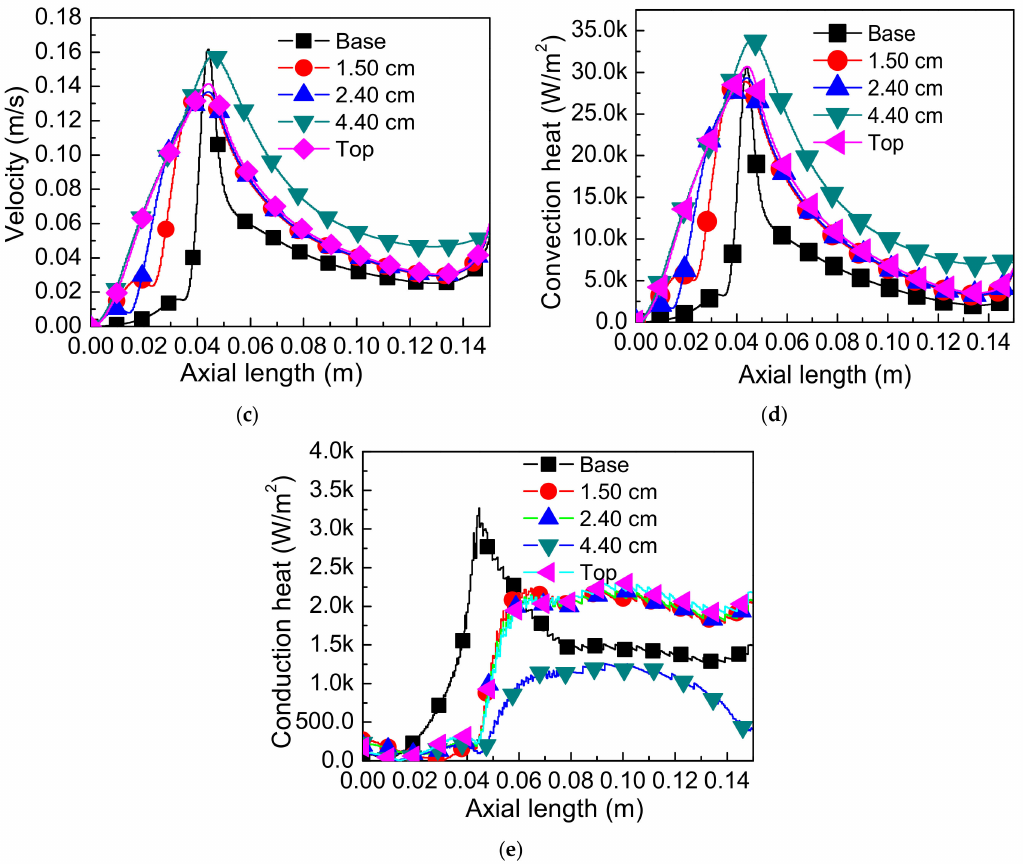
Figure 9. The distribution flux along the reactor at 150 kW / m 2 incident flux. 1 atm and 1.8 L / h for di ff erent fluid inlet positions: ( a ) Temperature distribution of the inlet positions from the base frustum; ( b ) Temperature distribution of the inlet positions from the top of the frustum; ( c ) Velocity distribution of inlets from the base of the frustum; ( d ) Convective heat flow distribution of the inlets from the base of the frustum and ( e ) Conduction heat transfer of the inlets from the base of the